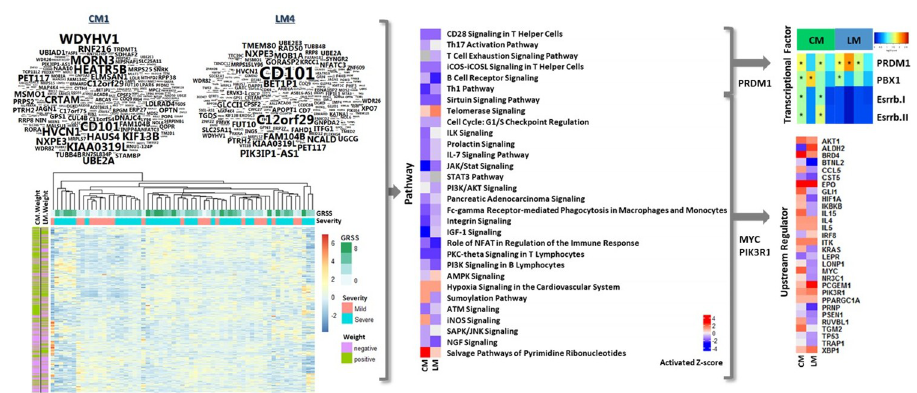
Fig 4. CD4 gene weights, expression, pathways, transcriptional factors and upstream regulators associated with clinical severity in integration models. Shown are an integration model of CD4, nasal epithelial cells and microbiota (CM) and a model of lymphocytes (LM). Weights generated by integration models are shown in word-clouds. The size of word represents the absolute value of gene weight. Word-clouds of CM & LM consist of genes that have absolute weight is greater than 0.0003. Gene expression are normalized expression levels for the 454 genes selected by univariate analysis; rows represent genes and columns represent samples. Red indicates higher expression, blue indicates low/no expression, green indicates Global RSV Severity Score (GRSS), soft orange indicates mild phenotype, lime green indicates severe phenotype, purple indicates negative weight and olive indicate positive weight. Transcriptional factors associated with severity in CD4 lymphocytes were identified using a hypergeometric test. Four transcriptional factors are shown where p-values were less than 0.05. Ingenuity Pathway Analysis (IPA) was used to identify canonical pathways and upstream regulators represented by genes associated with severity in CD4 lymphocytes. Thirty pathways and upstream regulators are shown where Fisher’s exact test p-values were less than 0.05. Red and blue indicate predicted increased or decreased pathway activation (activation z-score),